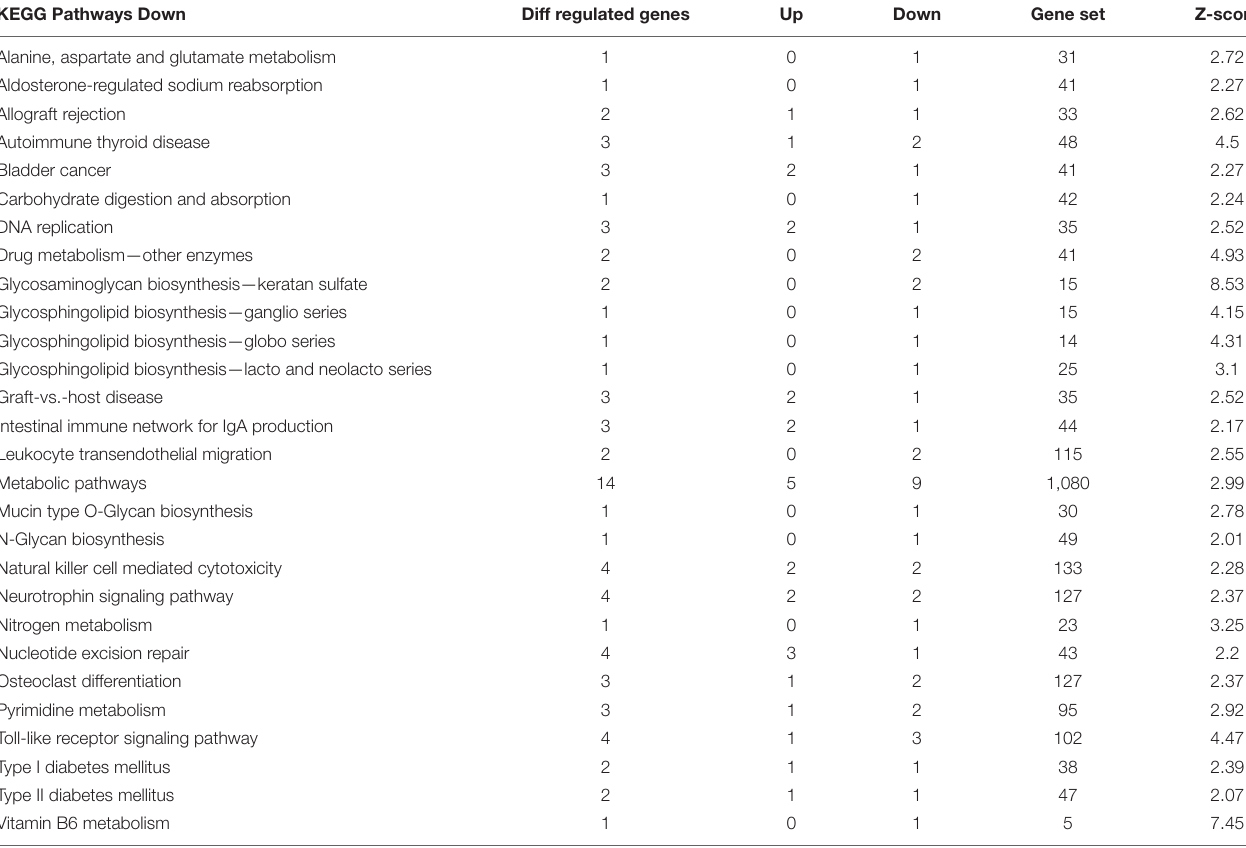
Table lists KEGG pathways that were significantly downregulated in PHT cells with rictor silencing as compared to control cells; “List” denotes the total number of differentially expressed genes on the array. “Up” denotes the number of up-regulated genes; “Down” denotes the number of down-regulated genes; “Gene set” denotes the total number of genes in this pathway that are included on the array and give a signal with PHT cell RNA; and “Z-score” denotes the z-score for the list pathway. The significance of identified KEGG pathways was determined by Z-score. Pathways were considered significantly different between scramble and Rictor siRNA groups if the Z-score for that pathway was > 2.00. The number of experiments (n) denotes the number of placentas studied, n = 4 placenta/each group, rictor siRNA and scramble